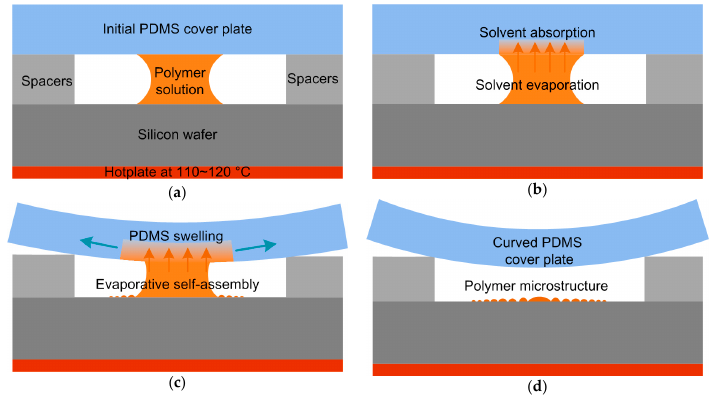
Figure 1. Schematic illustration of evaporating polymer solution in a flexible geometric confinement on a heated silicon wafer in the ( a ) initial state, ( b ) solvent absorption, ( c ) PDMS swelling, and ( d ) eventually curved state of the PDMS cover plate.